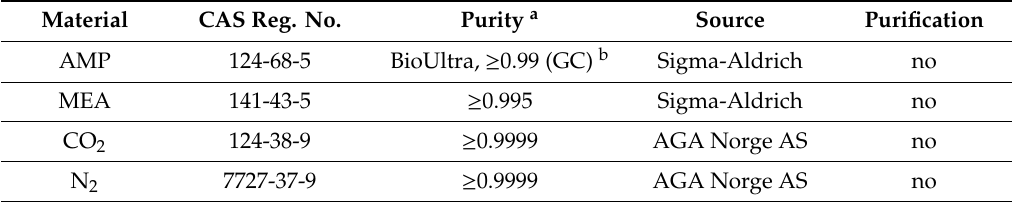
Table 1. Description of materials used for the